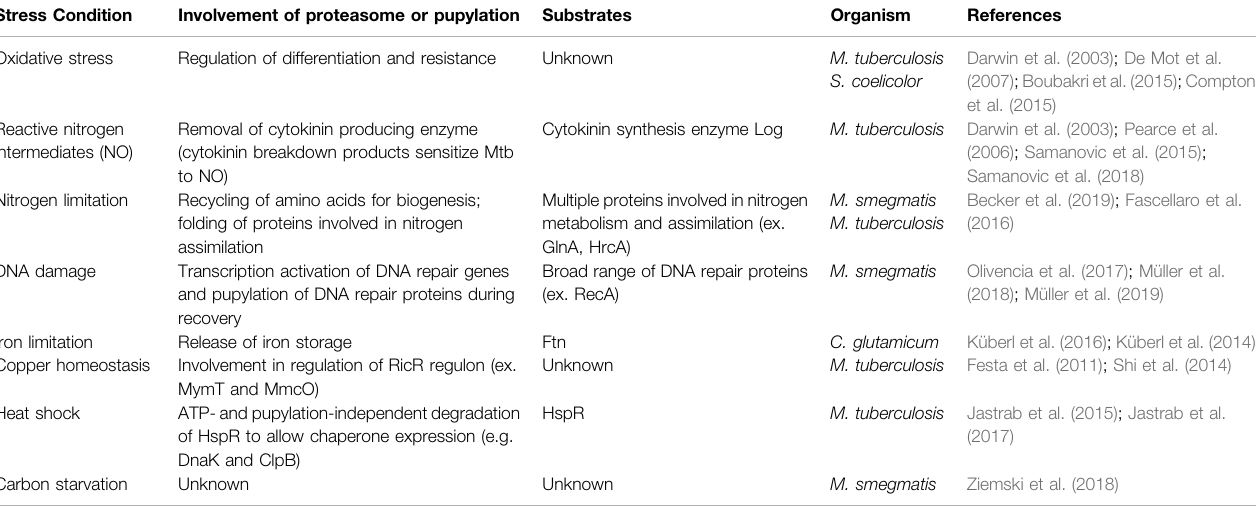
TABLE 1 | Overview of the involvement of the 20S proteasome in select stress conditions in various Actinobacteria described in this